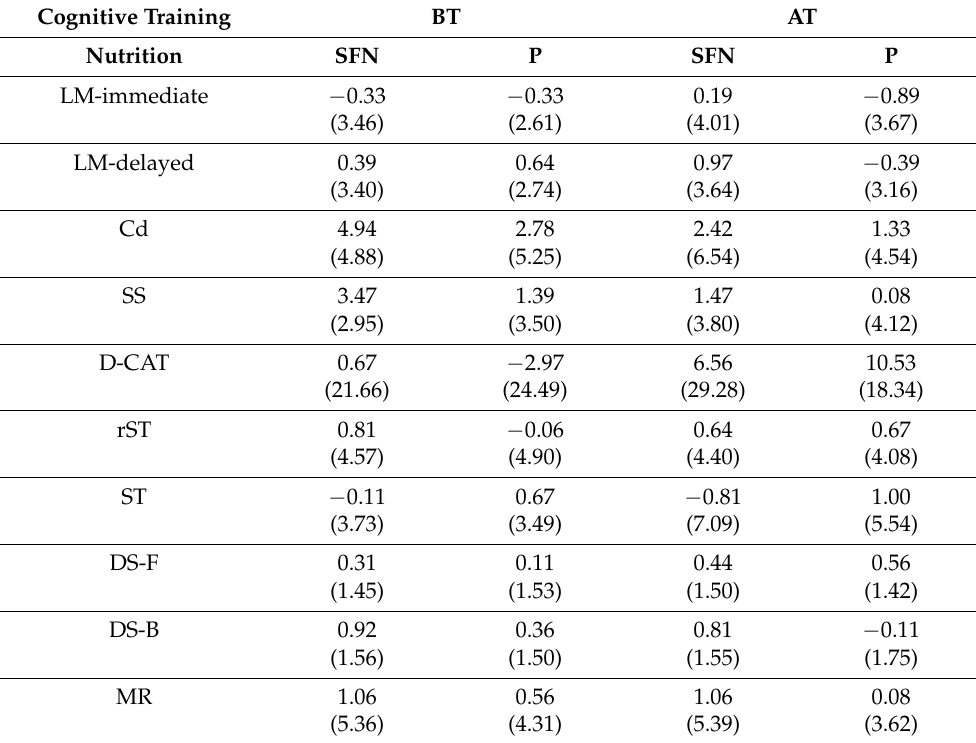
Table 3. Change scores of cognitive functions in all the participant groups. Cognitive